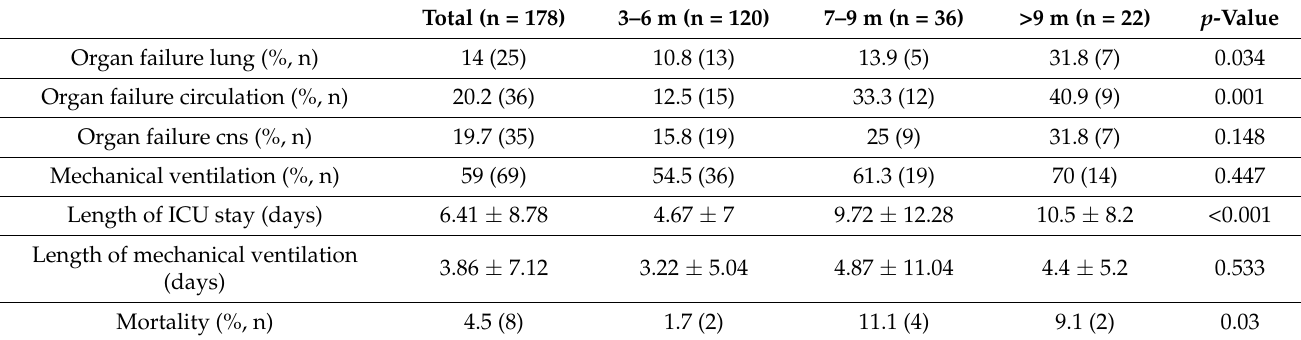
Table 4. Organ complications and outcome parameters. (CNS: central nerve system, ICU: Intensive Care